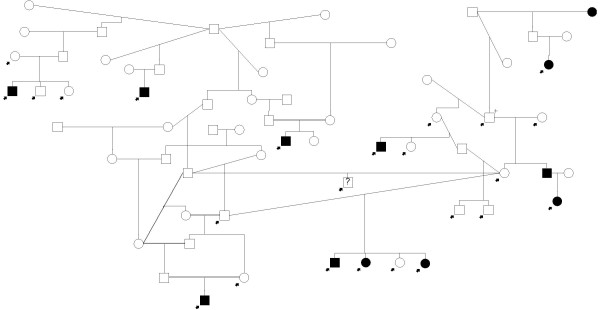
Vizsla linkage family 2 pedigree. Pedigree of Vizsla family 2. Squares and circles represent males and females, respectively. Filled shapes represent cases; those with question marks represent unknown phenotype status. Dogs with arrows were genotyped in this study. The dog marked with an arrow and a + is included on both families 1 & 2, effectively making this one very large family. The Vizsla pedigrees were broken into ten smaller families to decrease inbreeding loops before being analyzed in linkage analysis. Three dogs representing one of the ten sub-families are not shown on either pedigree.